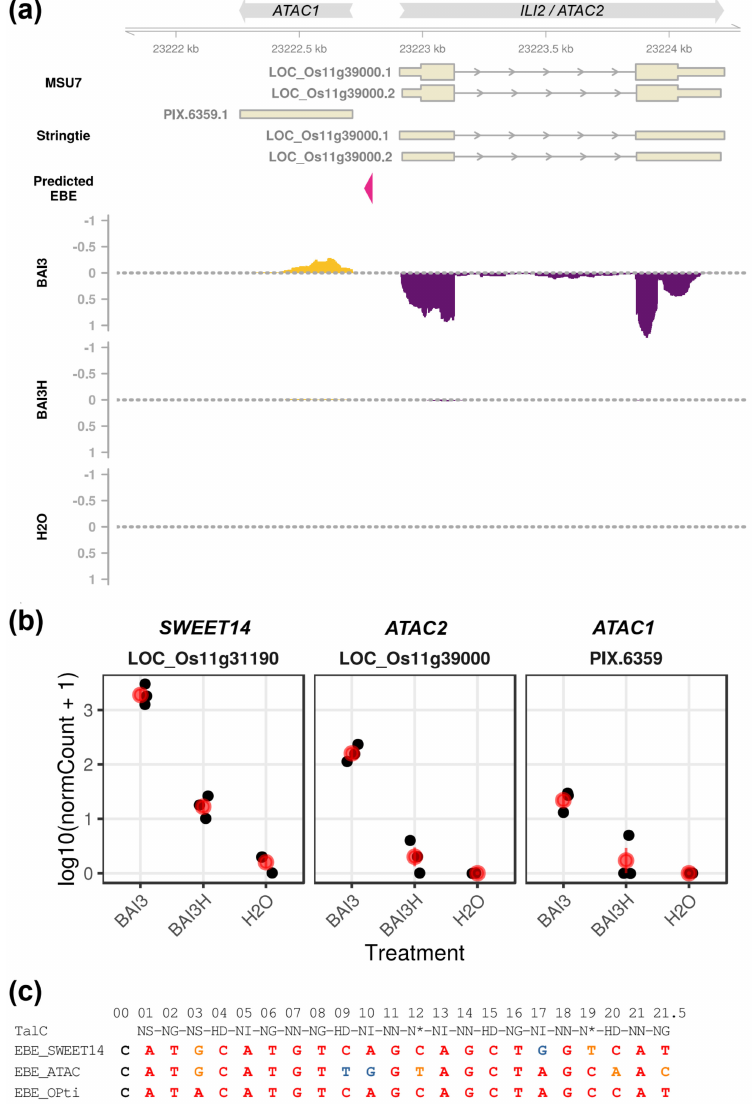
Figure 1. Transcripts at a second candidate target locus are potentially induced bidirectionally by TalC. ( a ) Genome browser snapshot of the ATAC locus with transcript annotation from MSU7, the experimental transcriptome annotation inferred by StringTie, the predicted TalC EBE and read coverage tracks (reads per million) for various experimental treatments in our mRNA-seq data. For the MSU7 annotation, shorter exon boxes correspond to untranslated regions. For coverage tracks, only the reads corresponding to the transcribed strand in paired-end data for a specific treatment were considered. Sequencing libraries were generated with RNA extracted 24 h after infiltration of Nipponbare leaves with the strains BAI3, BAI3H (T3SS-), and H 2 O. Coverage of reads mapping to the top genomic strand is represented with positive values and a golden-colored area, whereas coverage of reads mapping to the opposite strand is represented with negative values and a violet- colored area. ( b ) Expression of TalC target genes in our mRNA-seq data. Black dots correspond to individual replicate normalized count values, while the red dots and line ranges denote the mean and the standard error, respectively. ( c ) Alignment of the TalC RVD sequence and putative DNA target sequences. The numbers on top refer to the classical numbering of repeats in the TALE central repeat domain for TalC. The EBE Opti sequence was generated by concatenating the most probable nucleotide for each RVD in the RVD–nucleotide association matrix used by Talvez. In the alignment, nucleotides are colored according to their match to the corresponding TalC RVD in this matrix: red, best score; orange, intermediate; and blue, worst